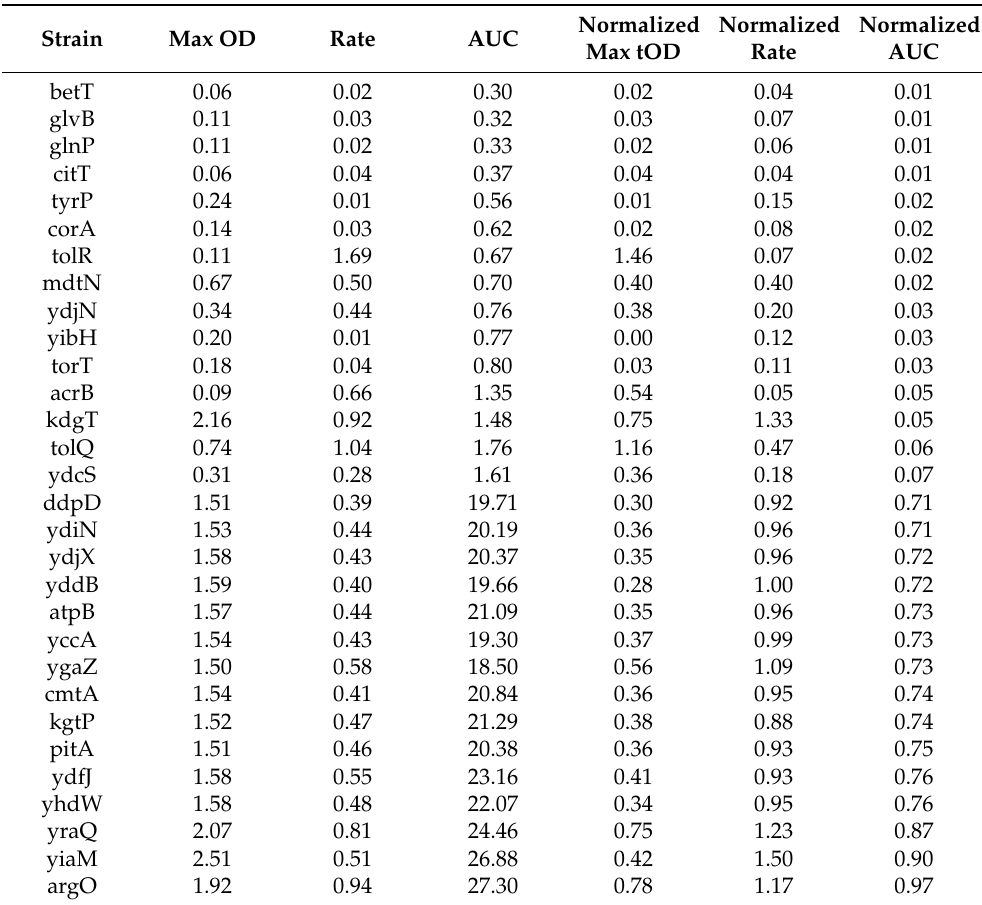
Table 3. Growth parameters for the 15 most sensitive and most resistant strains in ornidazole. Normalized values represent the value in ornidazole/value in LB for the given strain and values for the maximum OD, rate and area under the curve are